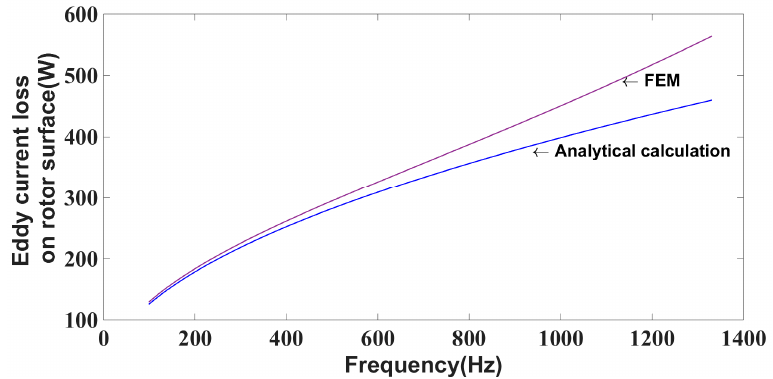
Figure 9. A comparison of the analytical calculation result with the FEM simulation result for a given load condition. Table 2. A comparison between analytical calculation and FEM simulation results under load. Frequency